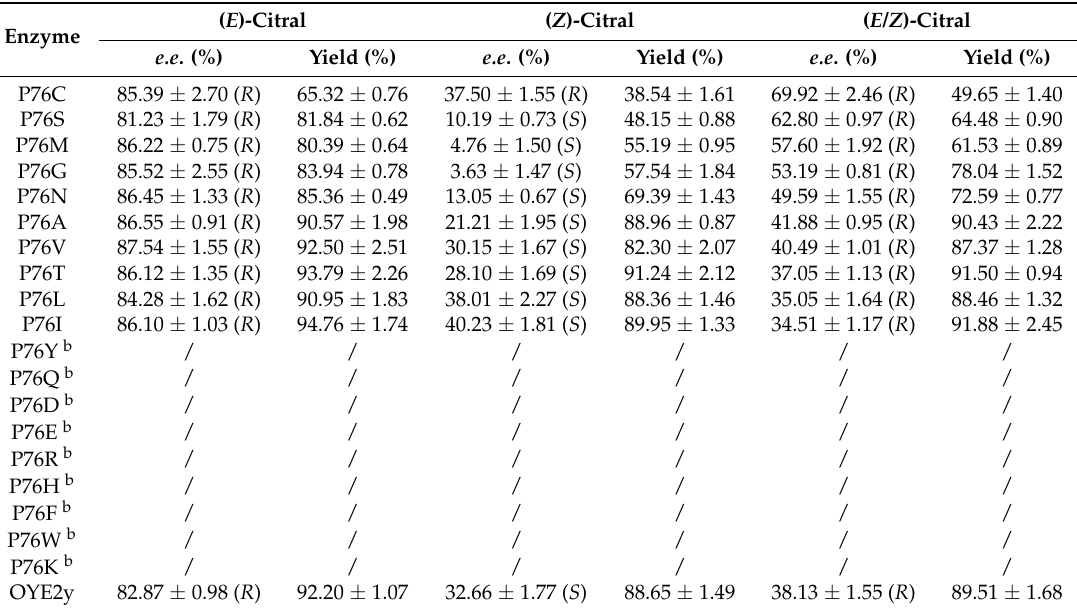
Table 3. The catalytic performance of OYE2y and its P76X variants a